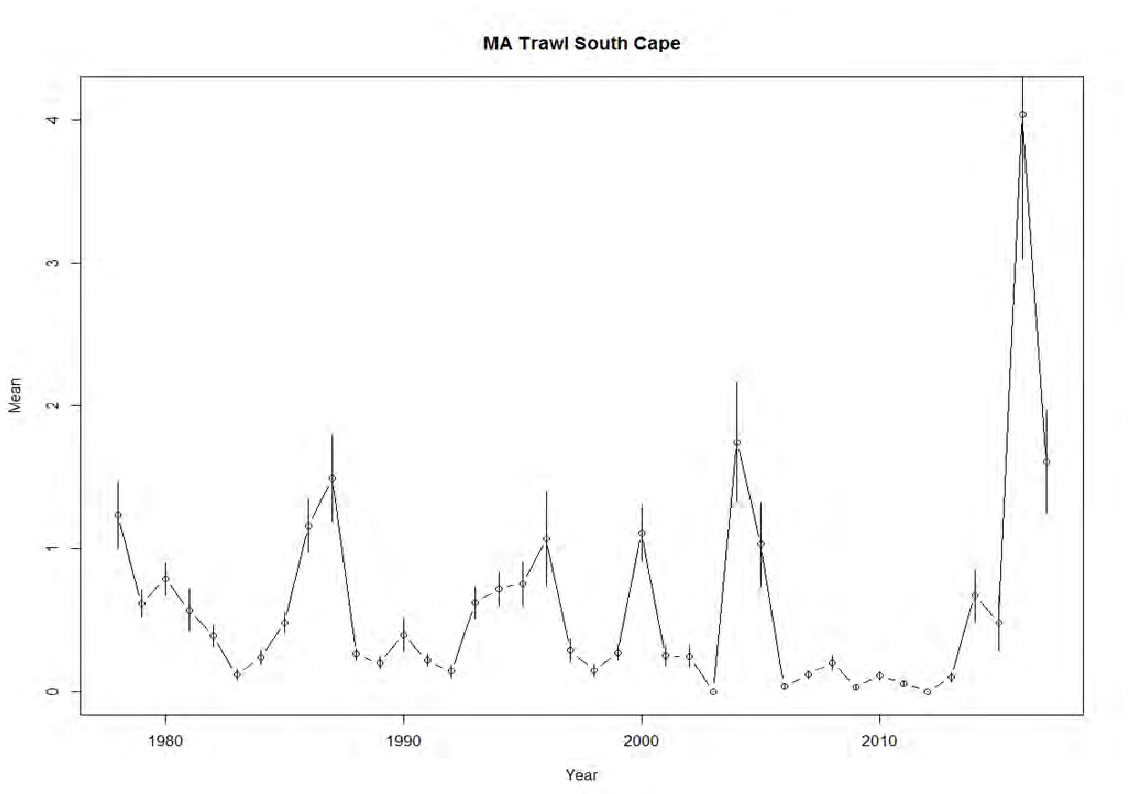
Figure 27. Index of relative abundance of horseshoe crab (delta mean catch per tow) developed from the fall portion of Massachusetts’ Resource Assessment Trawl Survey in strata south of Cape Cod with 95% confidence